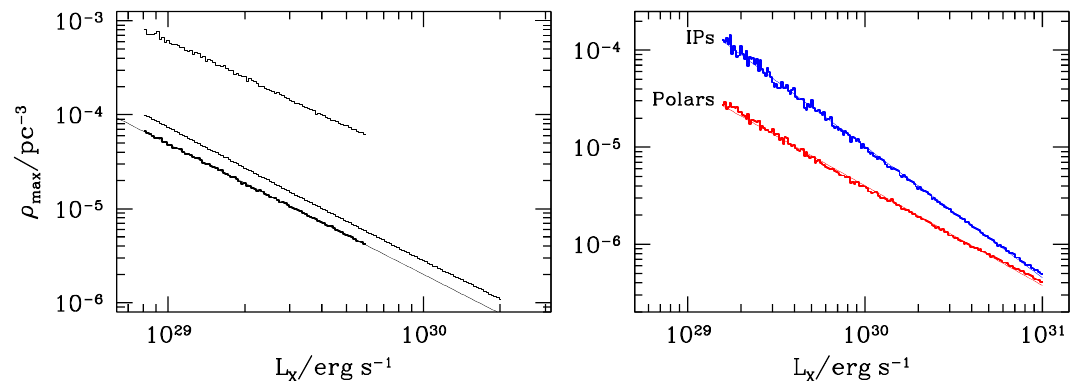
Figure 4: The upper limit on ρ as a function of X-ray luminosity for undetected populations of CVs. The left-hand panel is for non-magnetic CVs, and the right-hand panel for IPs (blue) and polars (red). In the left- hand panel, the 2 upper, fine histograms show the corresponding results for the RBS (middle) and NEP (top) surveys alone. Note that the assumed X-ray spectra of non-magnetic CVs, polars, and IPs are different, hence the different slopes. Reproduced from Pretorius & Knigge (2012) and Pretorius et al.